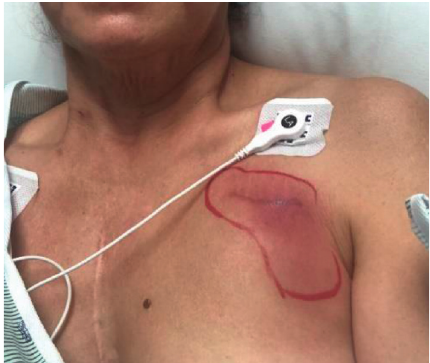
Figure 1: Pacemaker pocket site with developing erythema around surgical